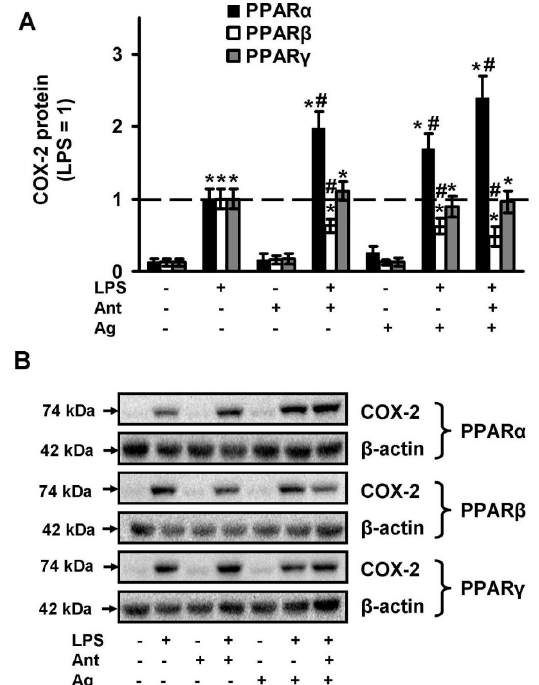
Figure 4. Effects of PPARs ligands on the expression of COX-2 upon stimulation with LPS. Astrocytes were pretreated with PPARα agonist Fenofibrate (50 μM), PPARα antagonist GW 6471 (5 μM), PPARβ agonist GW501516 (25 μM), PPARβ antagonist: GSK0660 (5 μM), PPARγ agonist Rosiglitazone (20 μM), PPARγ antagonist GW9662 (5 μM) for 30 min and then stimulated with LPS (100 ng/mL) for 4 h. COX-2 protein levels were evaluated by western blotting and normalized to the loading control β-actin. ( A ) Representative Western blots demonstrating COX-2 protein levels. ( B ) Results are expressed as fold-changes relative to LPS-treated astrocytes. The example is representative for three independent experiments. Values represent mean ± SEM from three independent experiments. * p < 0.05, compared with the unstimulated cells, # p < 0.05 compared with the LPS-stimulated cells.